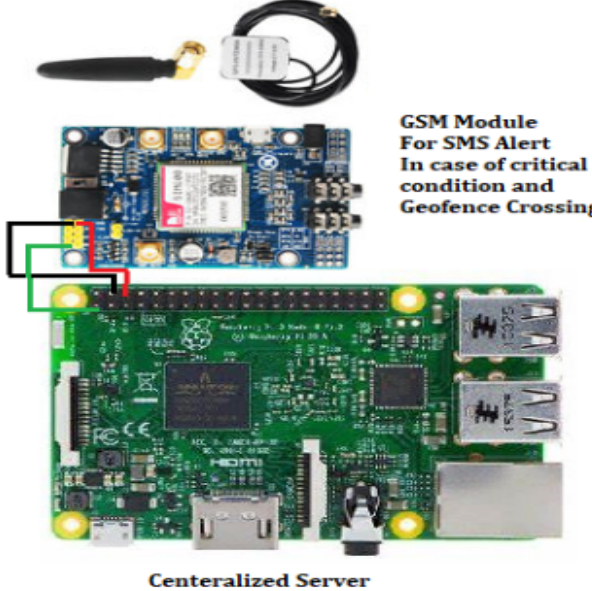
Figure 12. Raspberry Pi centralized Flask server for data collection and visualization.